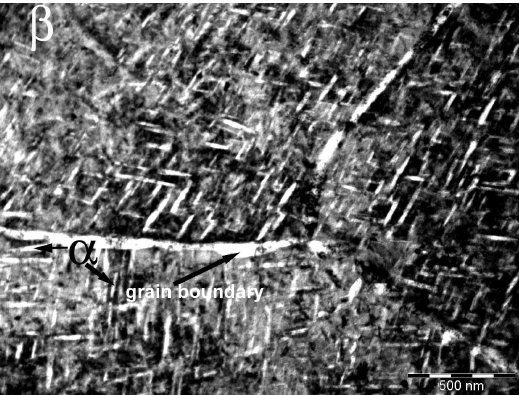
Figure 2. TEM image (bright-field) of Ti-12Mo-13Nb alloy hot swaged and aged at 500 °C/24 h showing a fine distribution of α precipitates in the β matrix.